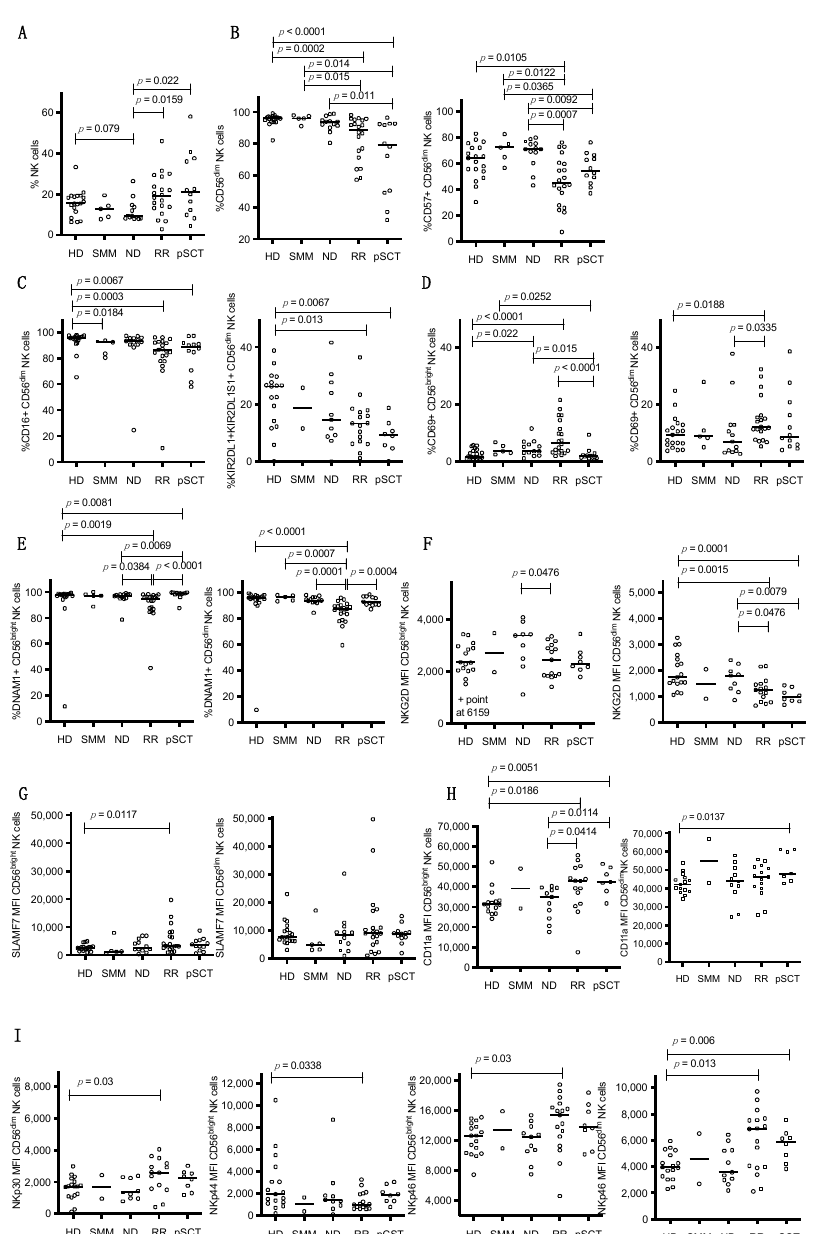
Figure 1. Percentages of various natural killer (NK) cell subsets and their expression of various NK cell markers in the blood of HDs and different MM patient subgroups. Each open circle designates a value for a distinct patient: HD = healthy donor, SMM = smoldering MM, ND = newly diagnosed, RR = relapsed/refractory, and pSCT = post-stem cell transplant, with horizontal lines marking medians. ( A ) The % of CD45 + CD3 − CD56 + NK cells in the viable lymphocyte gate. ( B ) % of total CD45 + CD3 − CD56 + NK cells that are CD56 dim (left) and % CD56 dim NK cells that are CD57 + (right), ( C ) % CD56 dim NK cells that are CD16 + (left) and % CD56 dim NK cells that are KIR2DS1 + and/or KIR2DL1 + (right), ( D ) % CD56 bright (left) and CD56 dim NK cells that are CD69 + (right), ( E ) % CD56 bright (left) and CD56 dim NK cells that are DNAM-1 + (right), ( F ) NKG2D expression level (NKG2D delta (d)MFI) on CD56 bright (left) and CD56 dim NK cells (right), ( G ) SLAMF7 expression level (SLAMF7 dMFI) on CD56 bright (left) and CD56 dim NK cells (right), ( H ) CD11a expression level (CD11a MFI) on CD56 bright (left) and CD56 dim NK cells (right), ( I ) natural cytotoxicity receptor (NCR) expression: NKp30 expression level (NKp30 dMFI) on CD56 dim NK cells, NKp46 expression level (NKp46 dMFI) on CD56 bright and CD56 dim NK cells, and NKp44 expression level (NKp44 MFI) on CD56 bright NK cells. Statistical comparisons between groups were calculated with an unpaired Wilcoxon rank-sum